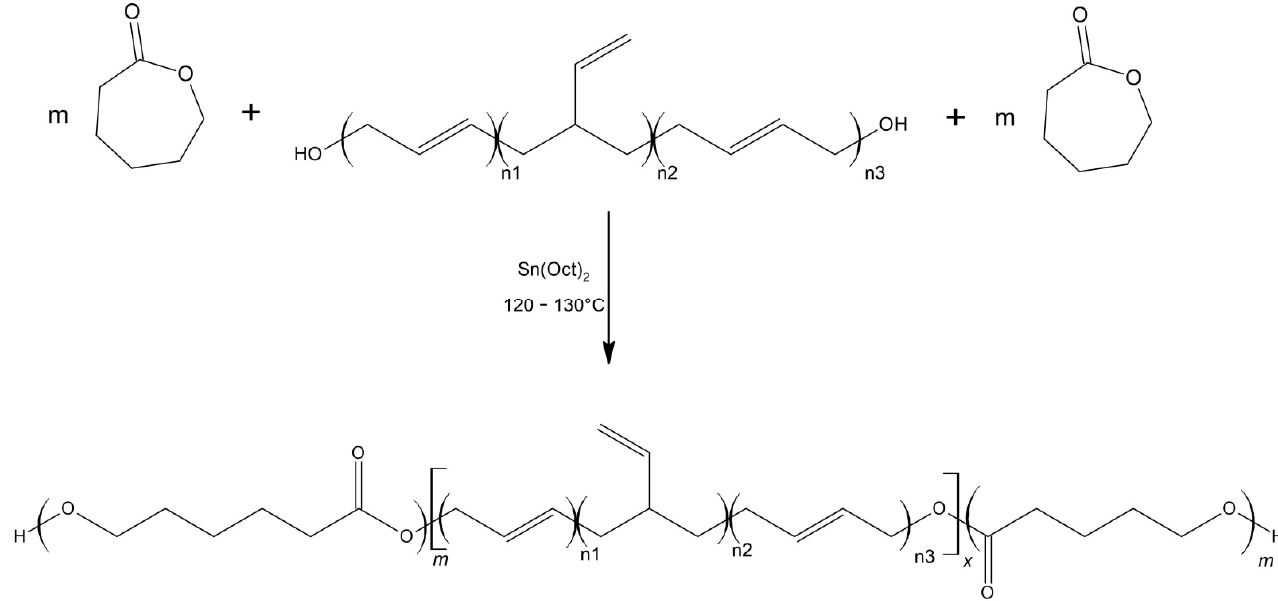
Figure 3. Synthesis of the hydroxyl terminated block copolymer